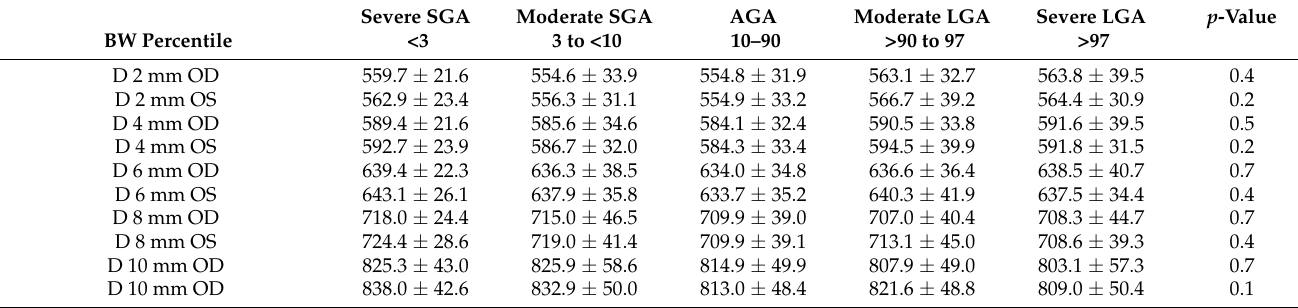
Table 4. Keratoconus indices of each study group. Table 3. Cont.